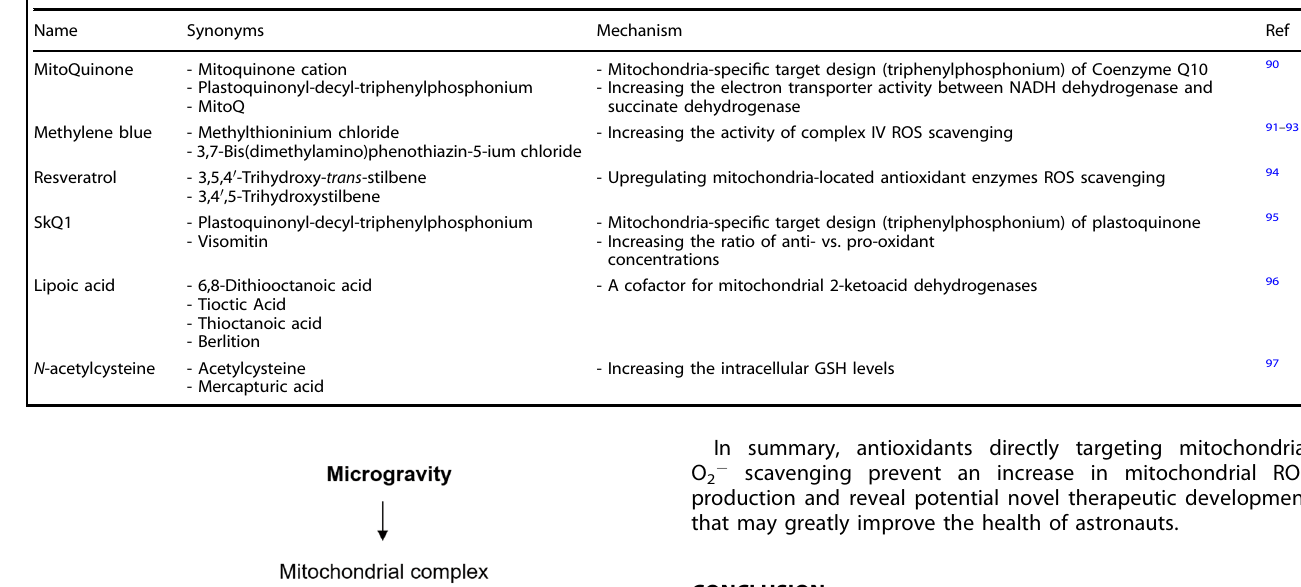
Table 1. Reported antioxidants applicable for space mitochondria stress.